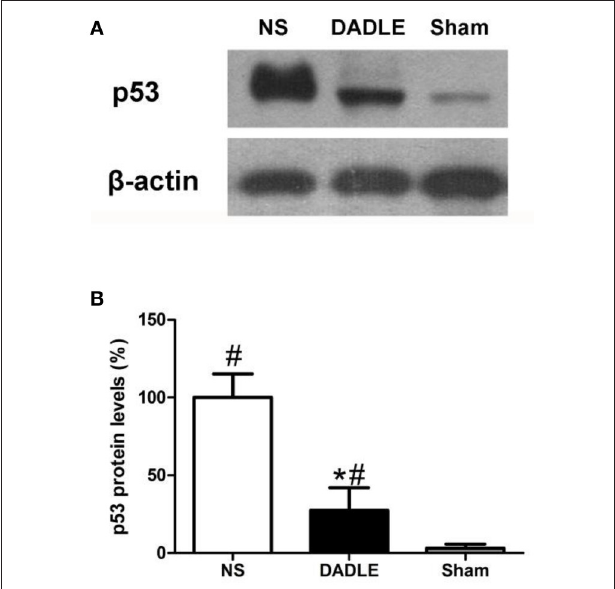
FIGURE 5 | Representative western blot of p53 (A) and quantitative analysis of p53 protein (B) in the ischemic spinal cords at 48h after reperfusion. The samples of spinal cords were harvested from the spinal cord I/R and sham rabbits at 48h after operation. The expression of p53 protein was up-regulated in the NS group, which was significantly decreased by DADLE treatment. Bars represent mean ± SD ( n = 6-8). * P < 0.05 vs. the NS group. # P < 0.05 vs. the Sham